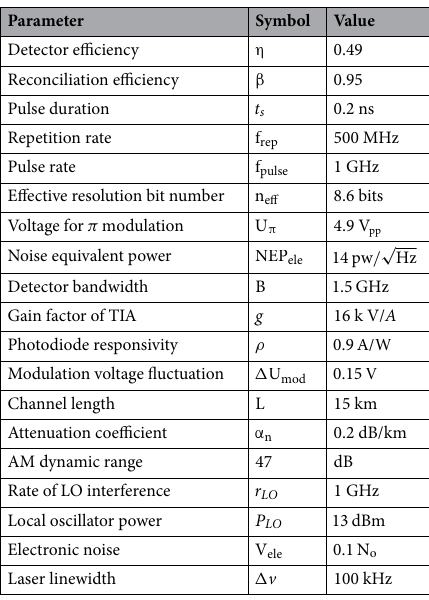
Table 1. Parameters used in the experiment.